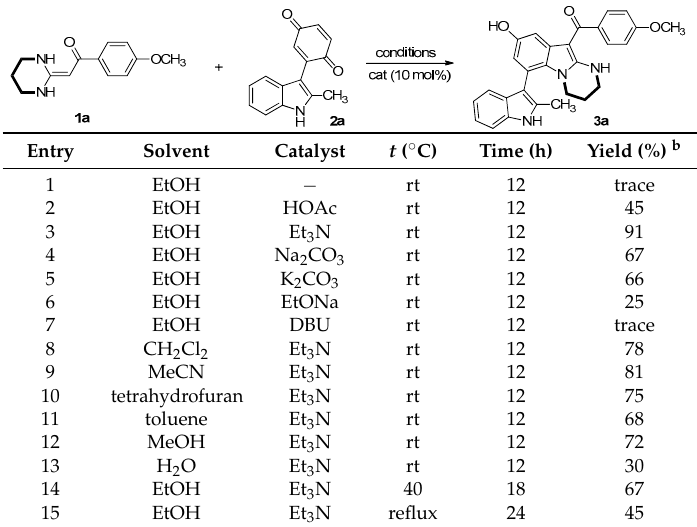
Table 1. Optimization of reaction conditions a .